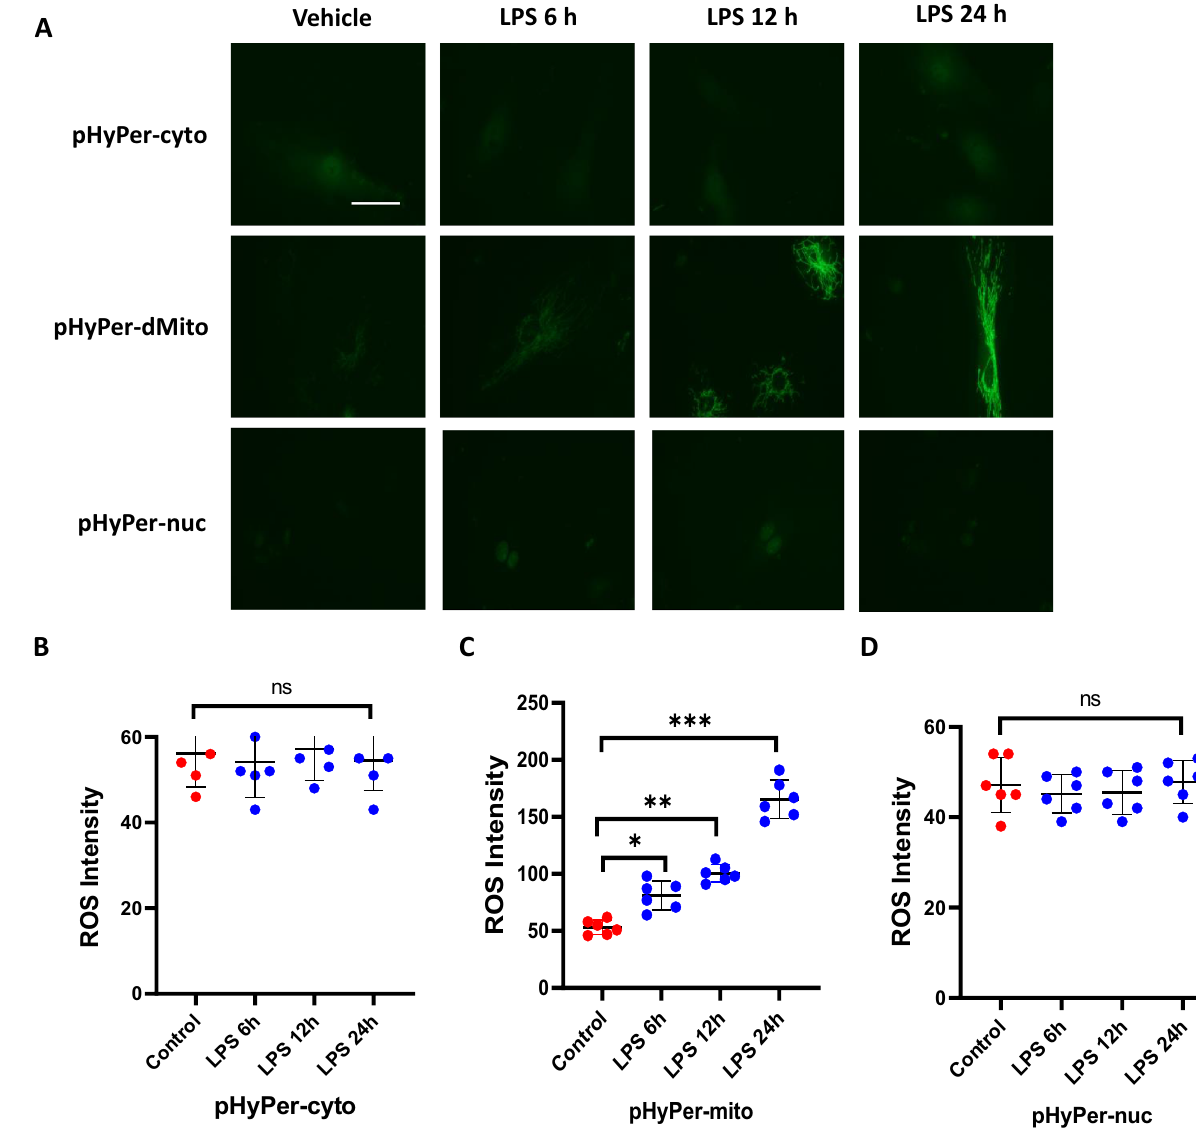
Figure 1. LPS induces mitochondrial ROS generation. ( A ) HLMVECs were transfected with ROS detector expressed in cytosol (pHyper Cyto), mitochondria (pHyper Mito), or nucleus (pHyper Nuclear). After 48 h of transfection, cells were treated with 100 ng/ml LPS or PBS for various time points. ROS images were acquired by fluorescent microscopy. Images were representative of 4–6 independent experiments. Scale bar: 5 μm. ( B ) Quantification of cytosol ROS, LPS did not induce significant ROS generation in cytosol. Data were presented as mean ± SD. ( C ) Quantification of mitochondrial ROS, data were presented as mean ± SD, *p < 0.05, LPS 6 h versus PBS control; **p < 0.01, LPS 12 h versus PBS control; ***p < 0.005, LPS 24 h versus PBS control. ( D ) Quantification of nuclear ROS, LPS did not induce significant nuclear ROS generation. Data were presented as mean ±